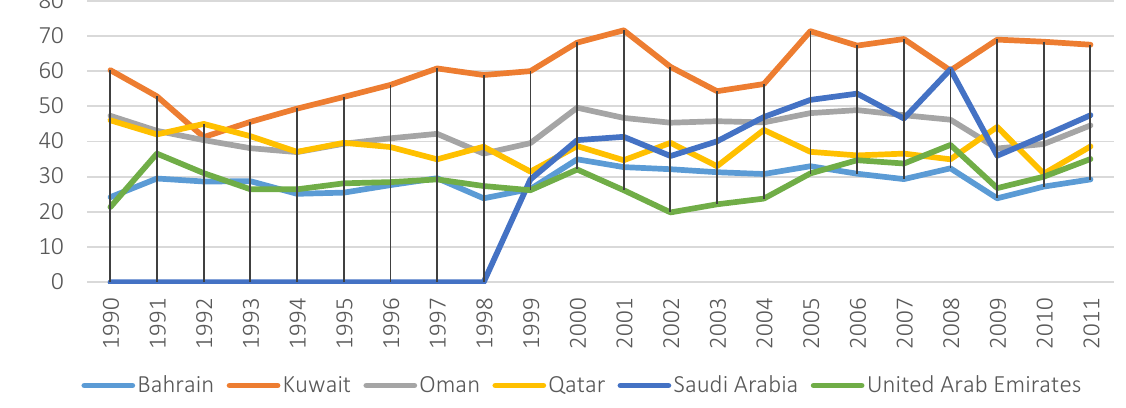
Figure 2. Government revenue (% of